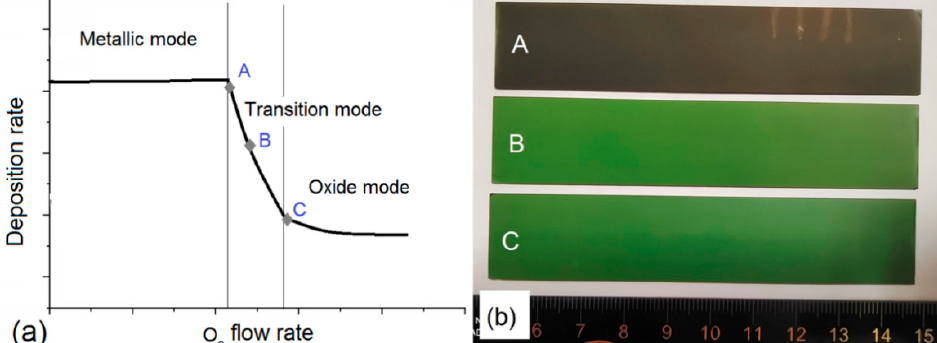
Figure 2. Dependence between YSZ electrolyte film deposition and oxygen flow rates ( a ); a photo- graph of electrolyte films deposited at A , B , C points ( b ).